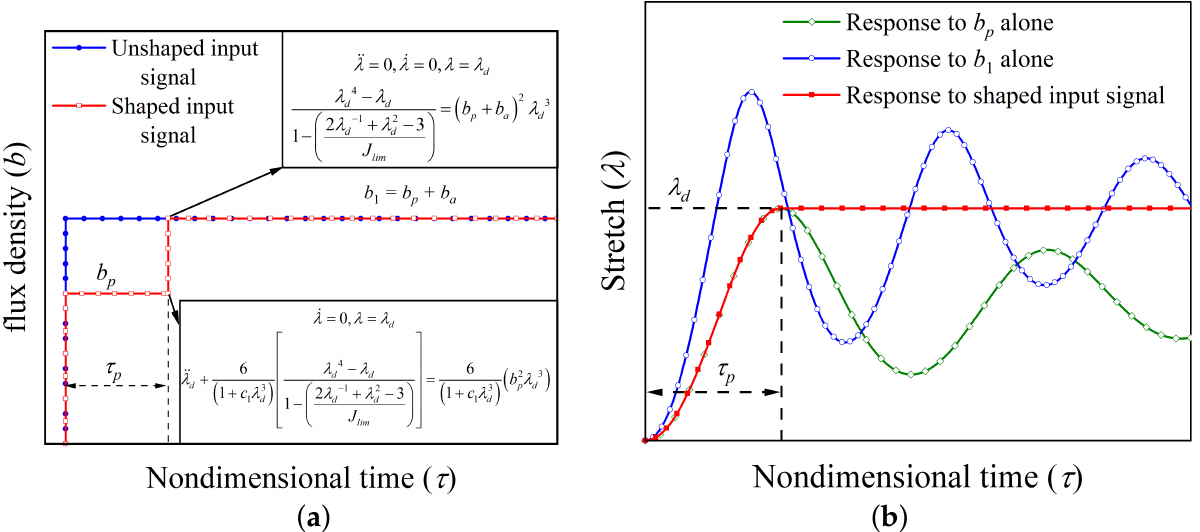
Figure 3. ( a ) Shaped and Unshaped magnetic flux density input signals showing the equations governing the actuator motion at two critical points, and ( b ) the transient response of the hard- magnetic soft actuator subjected to shaped and unshaped input signals.